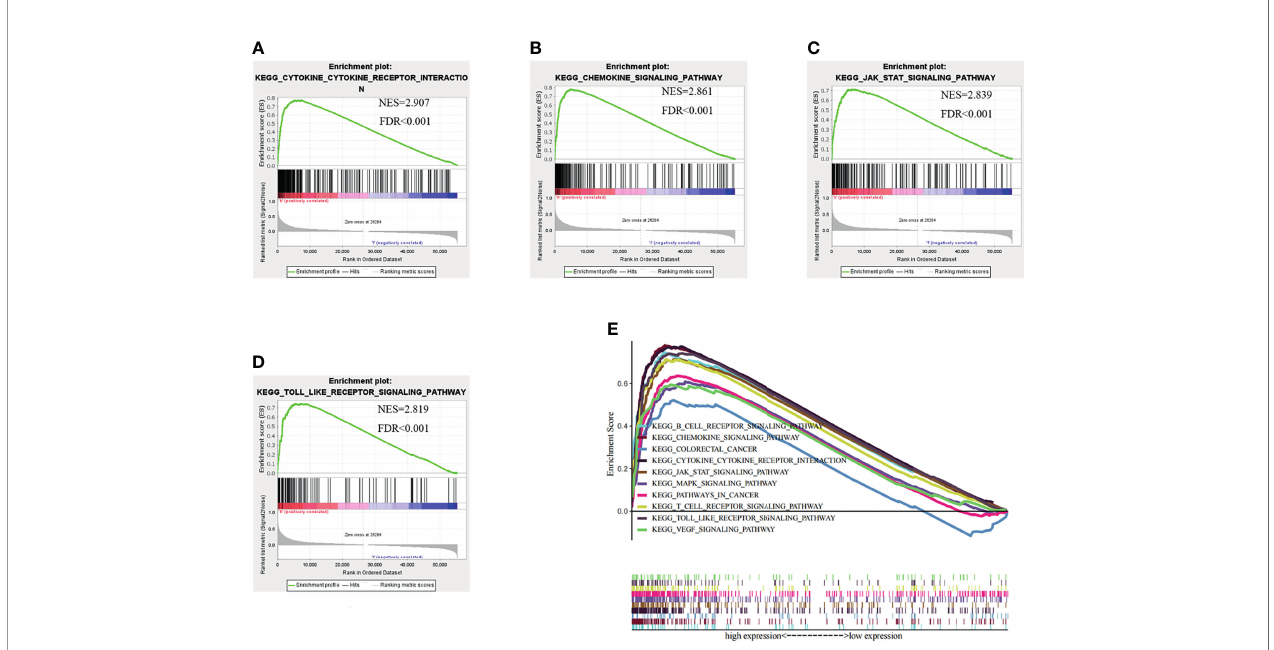
FIGURE 4 | Gene set enrichment analysis (GSEA) results based on the CSF-1R expression in COAD from TCGA dataset. (A) Cytokine-Cytokine receptor interaction pathway. (B) Chemokine signaling pathway. (C) JAK-STAT signaling pathway. (D) Toll like receptor signaling pathway. (E) The ten signi fi cantly enriched signaling pathways based on their normalized enrichment score and the expression map.